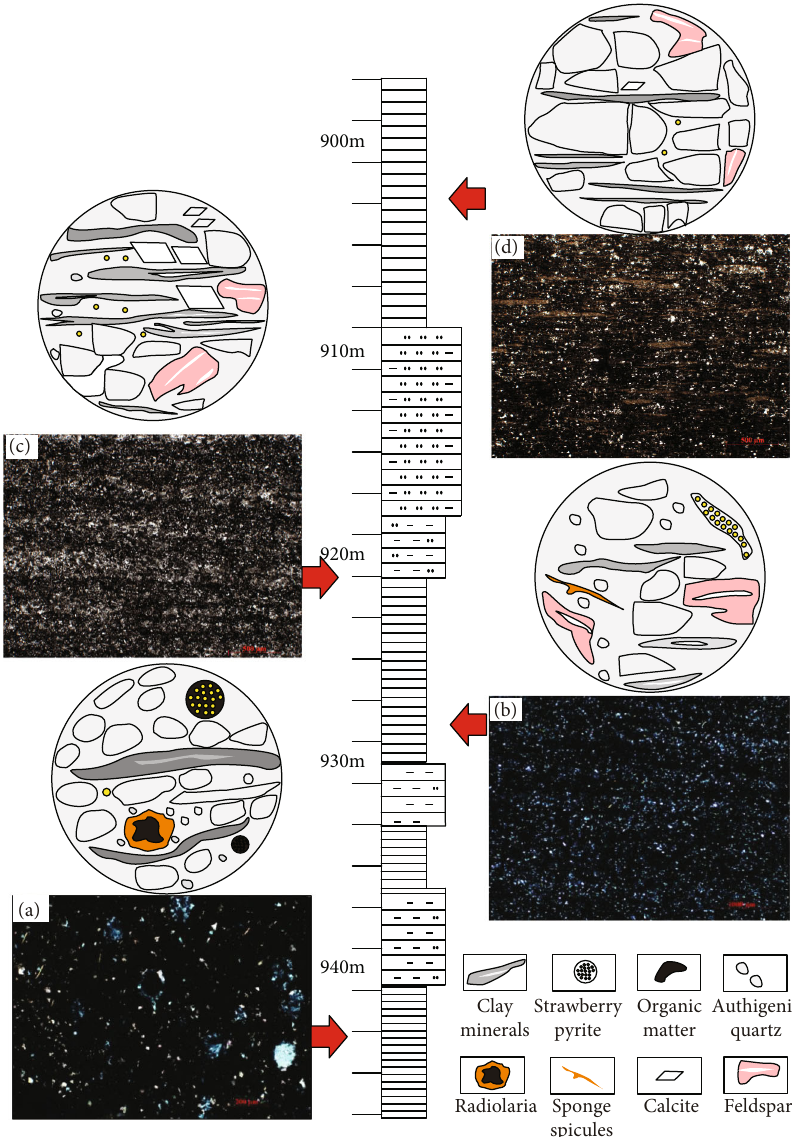
Figure 4: Lithofacies characteristics of the Longmaxi Formation in well